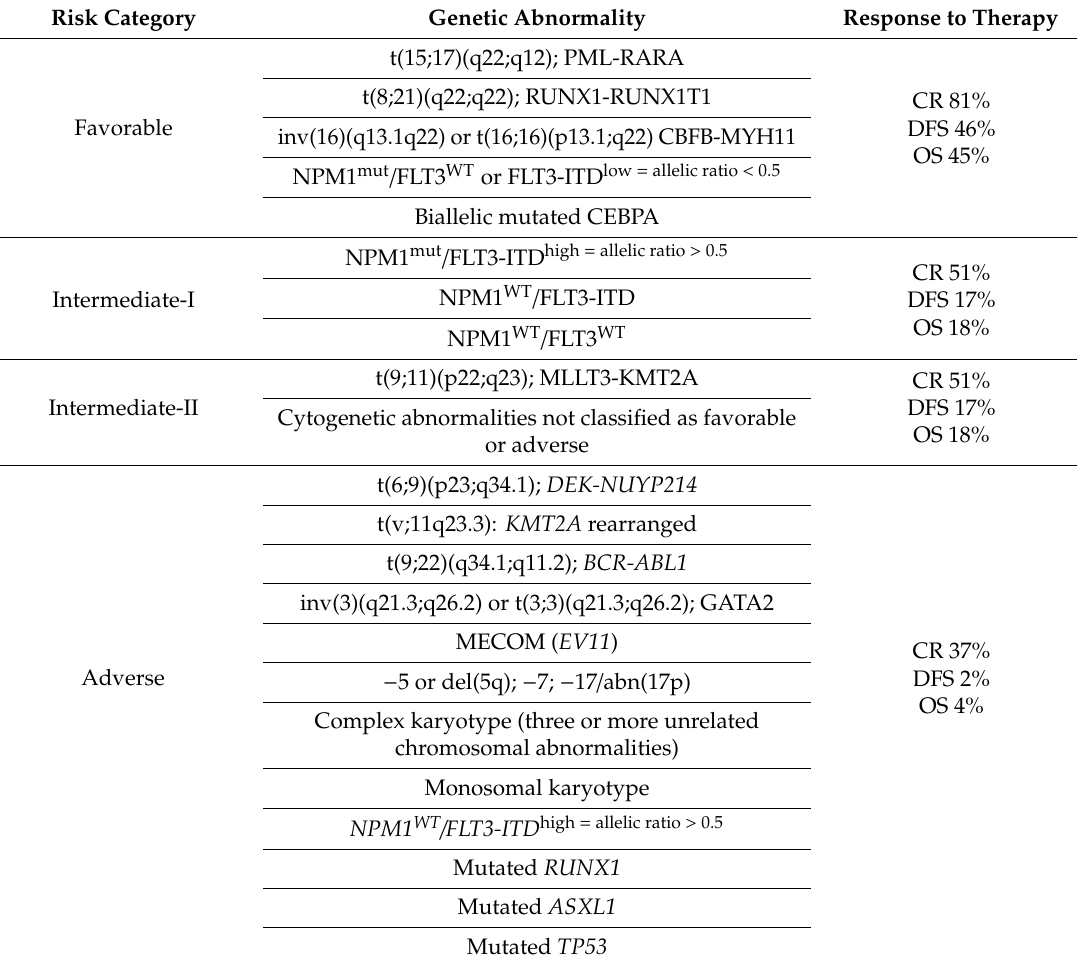
Table 1. European Leukemia NET (ELN)-risk stratification of molecular, genetic and cytogenetic acute myeloid leukemia (AML) alterations. Response rates were reported also, including CR (complete response), DFS (3-year, disease-free survival) and CR (3-year, overall